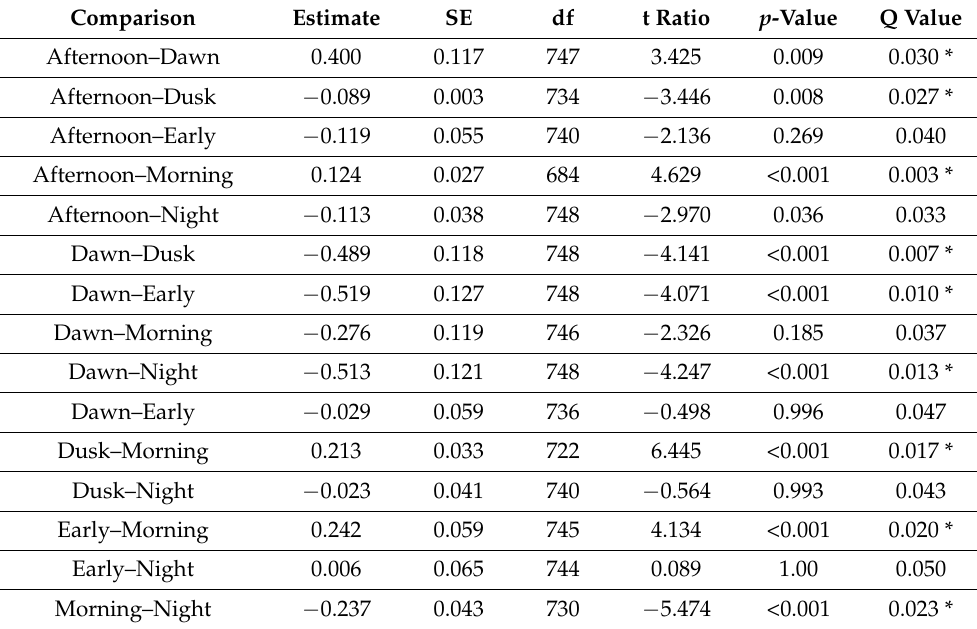
Table 2. Post—hoc comparison of outdoor activity by time of day. Significant differences are marked with an asterisk.